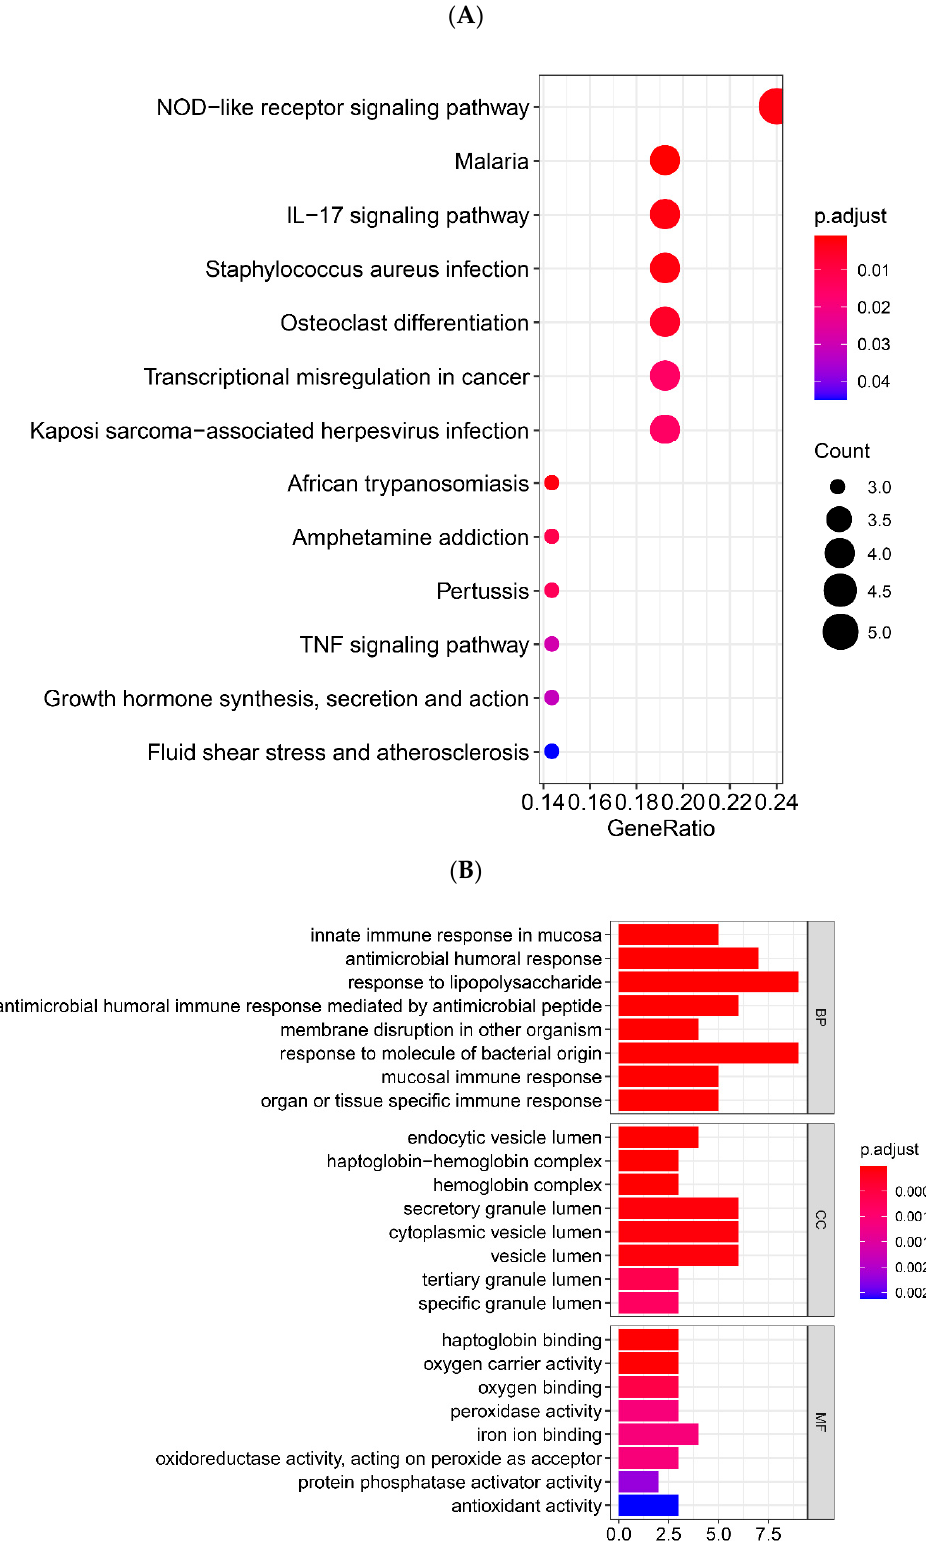
Figure 4. GO and KEGG enrichment analysis of black modules. ( A ) KEGG pathway analysis of black modules. ( B ) GO function enrichment analysis of black